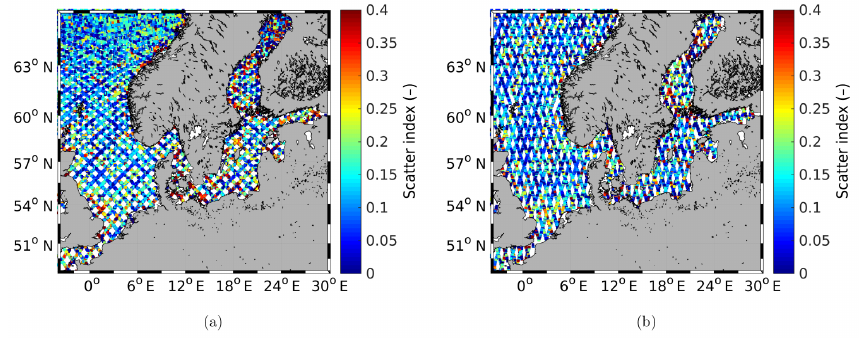
Figure 8. Scatter index between satellite and modelled significant wave heights along the satellite tracks for (a) Jason-2 and (b) Sentinel-3A